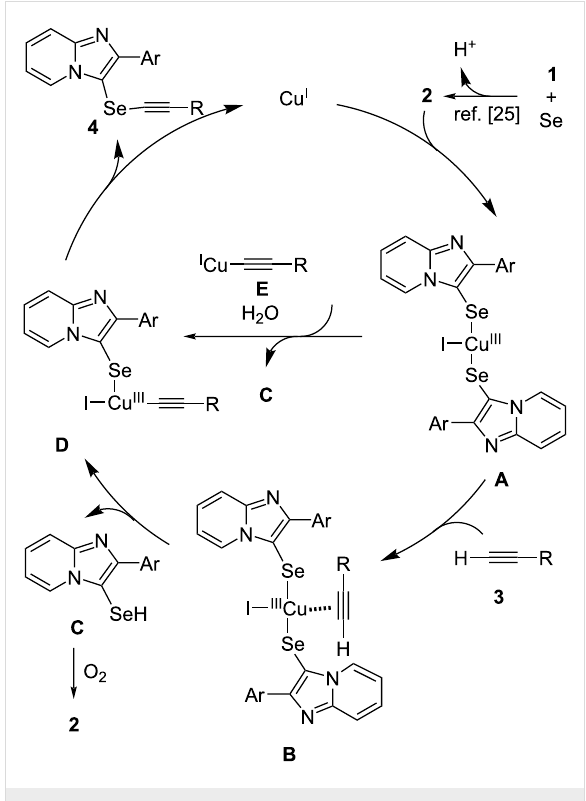
Figure 3: Proposed mechanism.